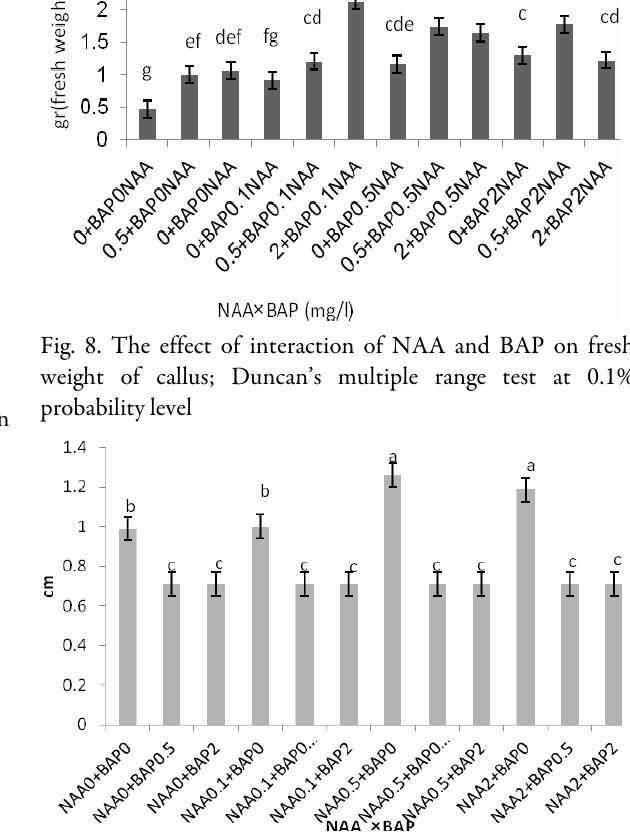
Fig. 9. Different concentrations of growth regulators with sucrose and glucose for the establishment of suspension culture of A. annua